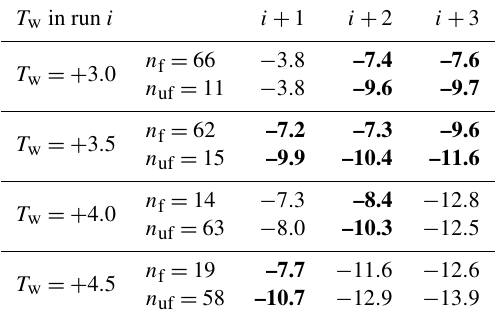
Table 4. Comparison of the average freezing temperatures T ∗ runs i + 1, i + 2, i + 3 for the n f drops frozen with T ∗ i against the n uf drops that froze below that limit. The comparison is given for four different values of T w . Bold font indicates differences exceeding 2 ◦